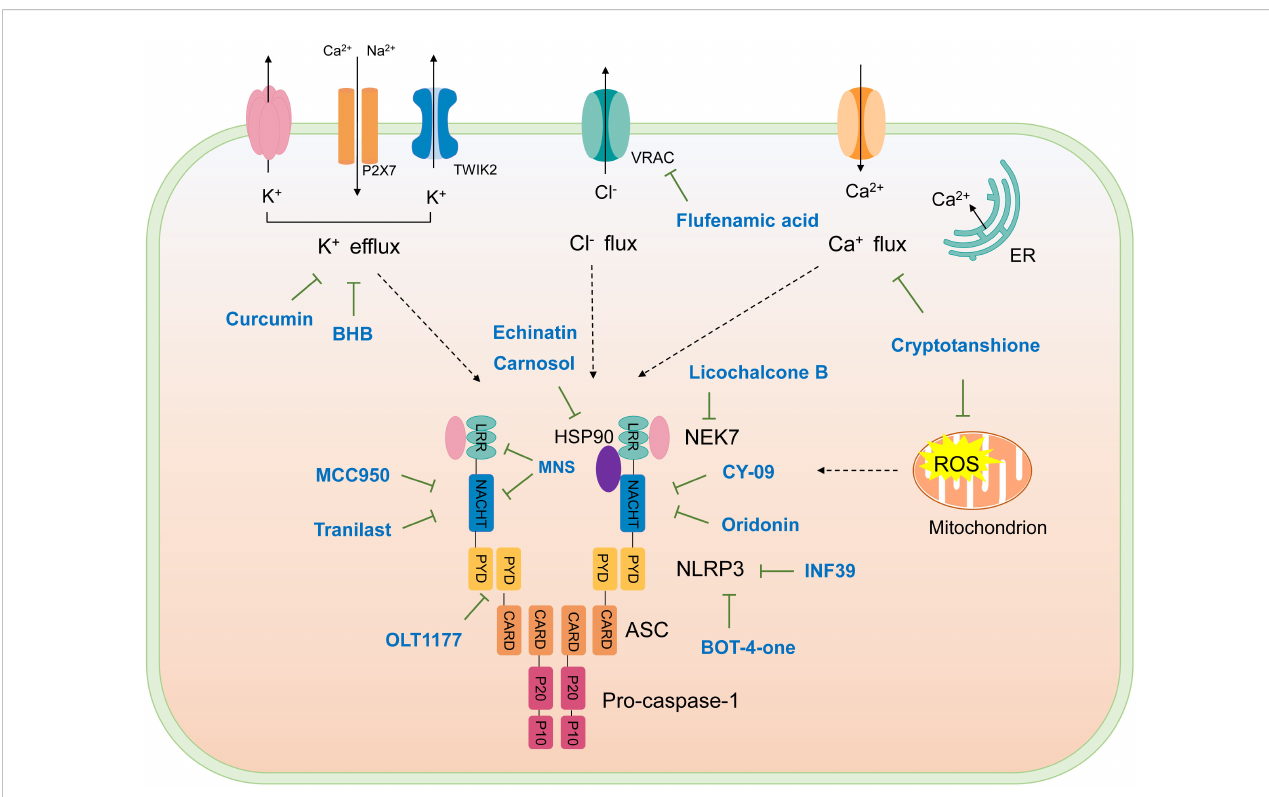
FIGURE 4 Schematic illustration of targets of NLRP3 in fl ammasome inhibitors. Upon activation, NLRP3 oligomerizes through interactions between NACHT domains, then recruiting ASC via PYD-PYD interactions, assembled ASC recruits caspase-1, forming NLRP3 in fl ammasome. NKE7 binds to NLRP3; the interaction is